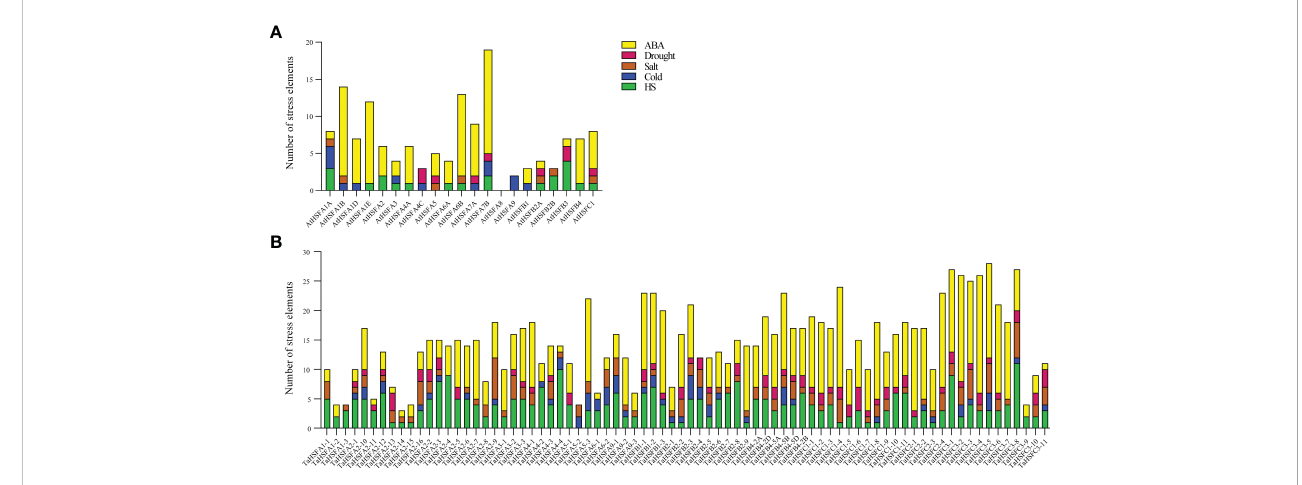
FIGURE 2 Abiotic stress cis -regulating element counts included in promoters of AtHSFs and TaHSFs . (A) The abiotic stress cis -element counts included in AtHSFs promoters. (B) The abiotic stress cis -element counts included in TaHSFs